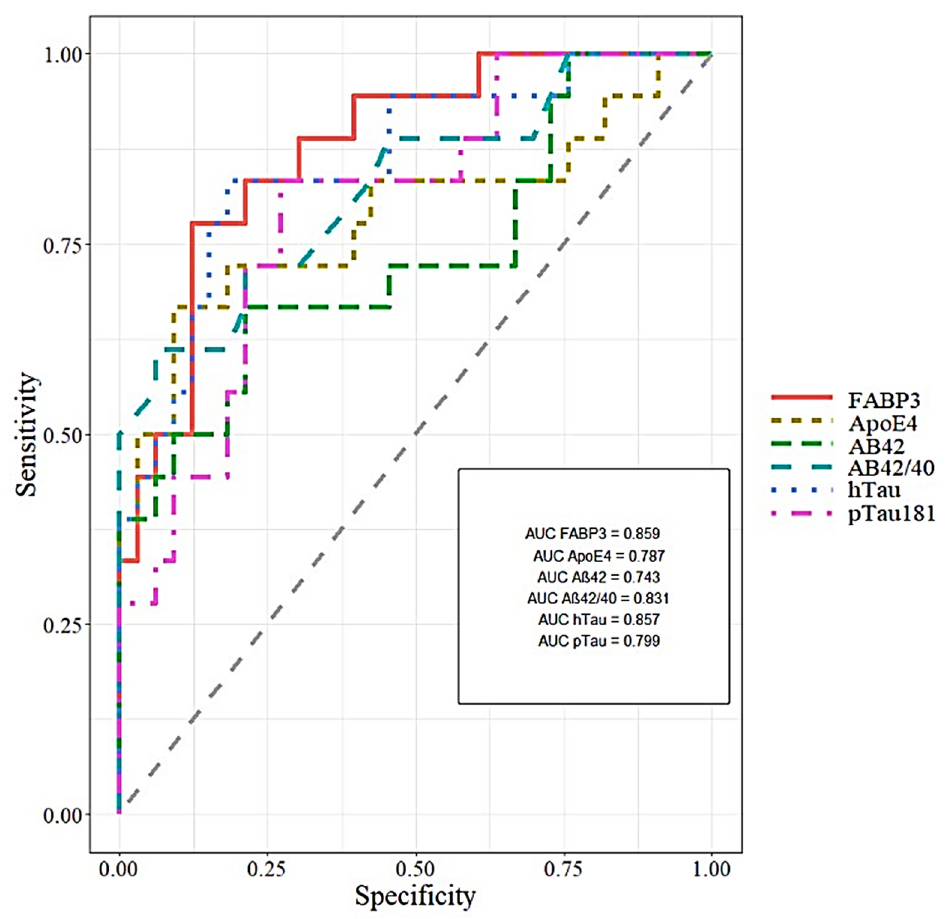
Figure 3. Areas under ROC curves (AUC) for CSF FABP3, ApoE4 and classical biomarkers in MCI compared to AD.